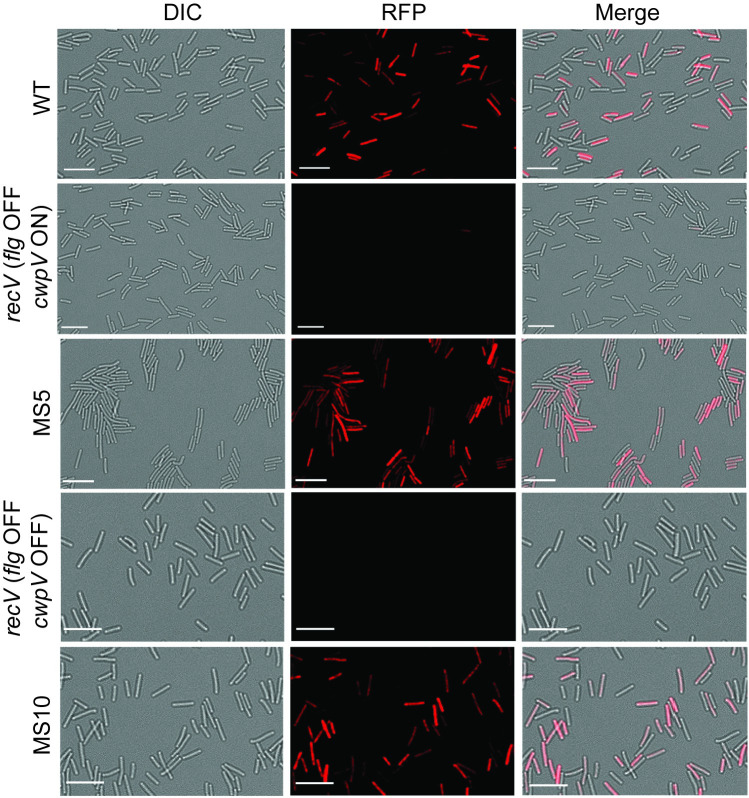
Rho inhibits heterogeneous flagellar gene expression in a recV flg OFF background.Micrographs of C. difficile R20291 (WT), MS5 and its recV flg OFF cwpV ON parent (RT1694), and MS10 and its recV flg OFF cwpV OFF parent (RT1693) transformed with the pPflgM::mCherryOpt reporter plasmid. Representative images for three independent experiments. Channels used are indicated for each column. White bars = 10 microns.